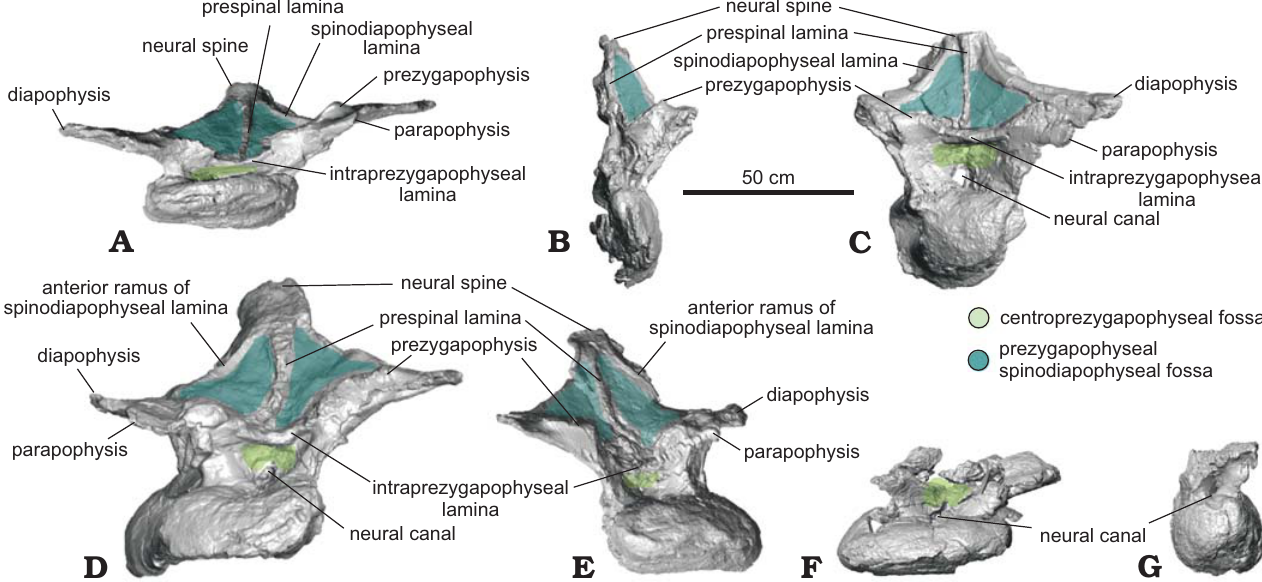
Fig. 2. Nearly complete dorsal vertebrae of titanosaurian sauropod Dreadnoughtus schrani Lacovara, Lamanna, Ibiricu, Poole, Schroeter, Ullmann, Voegele, Boles, Carter, Fowler, Egerton, Moyer, Coughenour, Schein, Harris, Martínez, and Novas, 2014, from Santa Cruz Province, Argentina; middle–late Campanian to early Maastrichtian; in anterior view. A . MPM-PV 1156?-4, estimated as the ~4 th dorsal vertebra. B . MPM-PV 1156?-5, ~5 th . C . MPM-PV 1156-6, ~6 th .